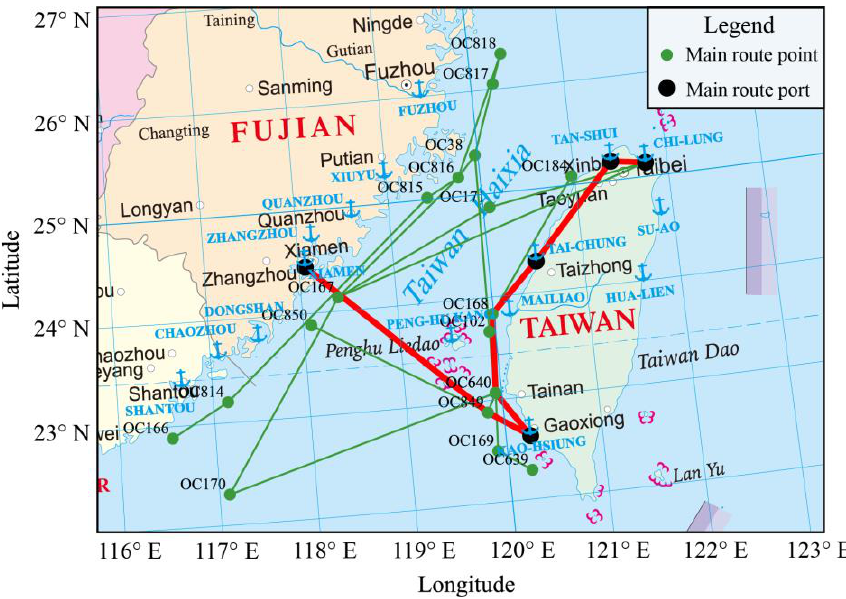
Figure 12. Route map of Taiwan Strait based on the Ocean Passages for the World.